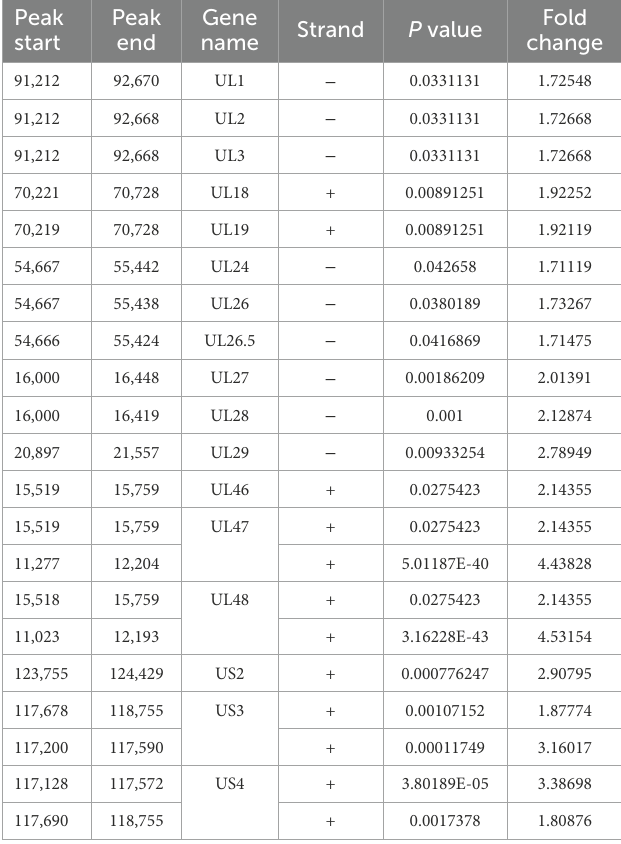
TABLE 1 Integration statistics of significant m 6 A peaks